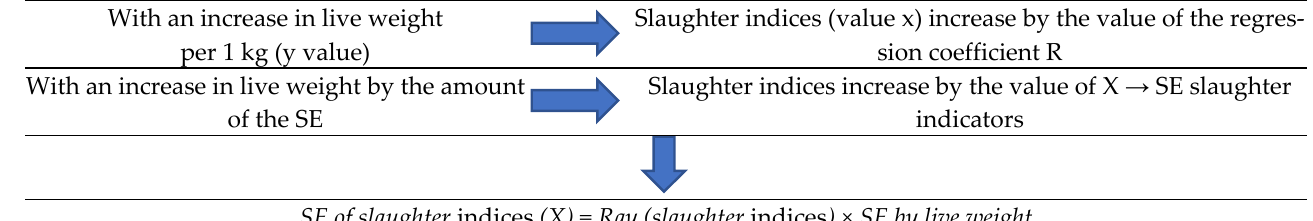
Figure 2. Calculation of the selection effect (SE) using the regression coefficient.